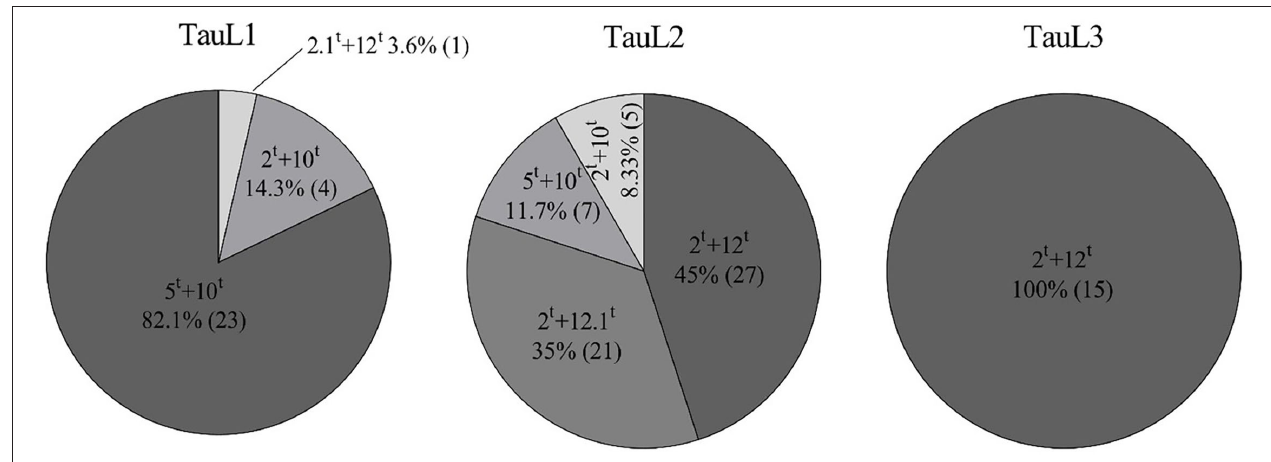
MSD refers to multiple synthetic derivatives.